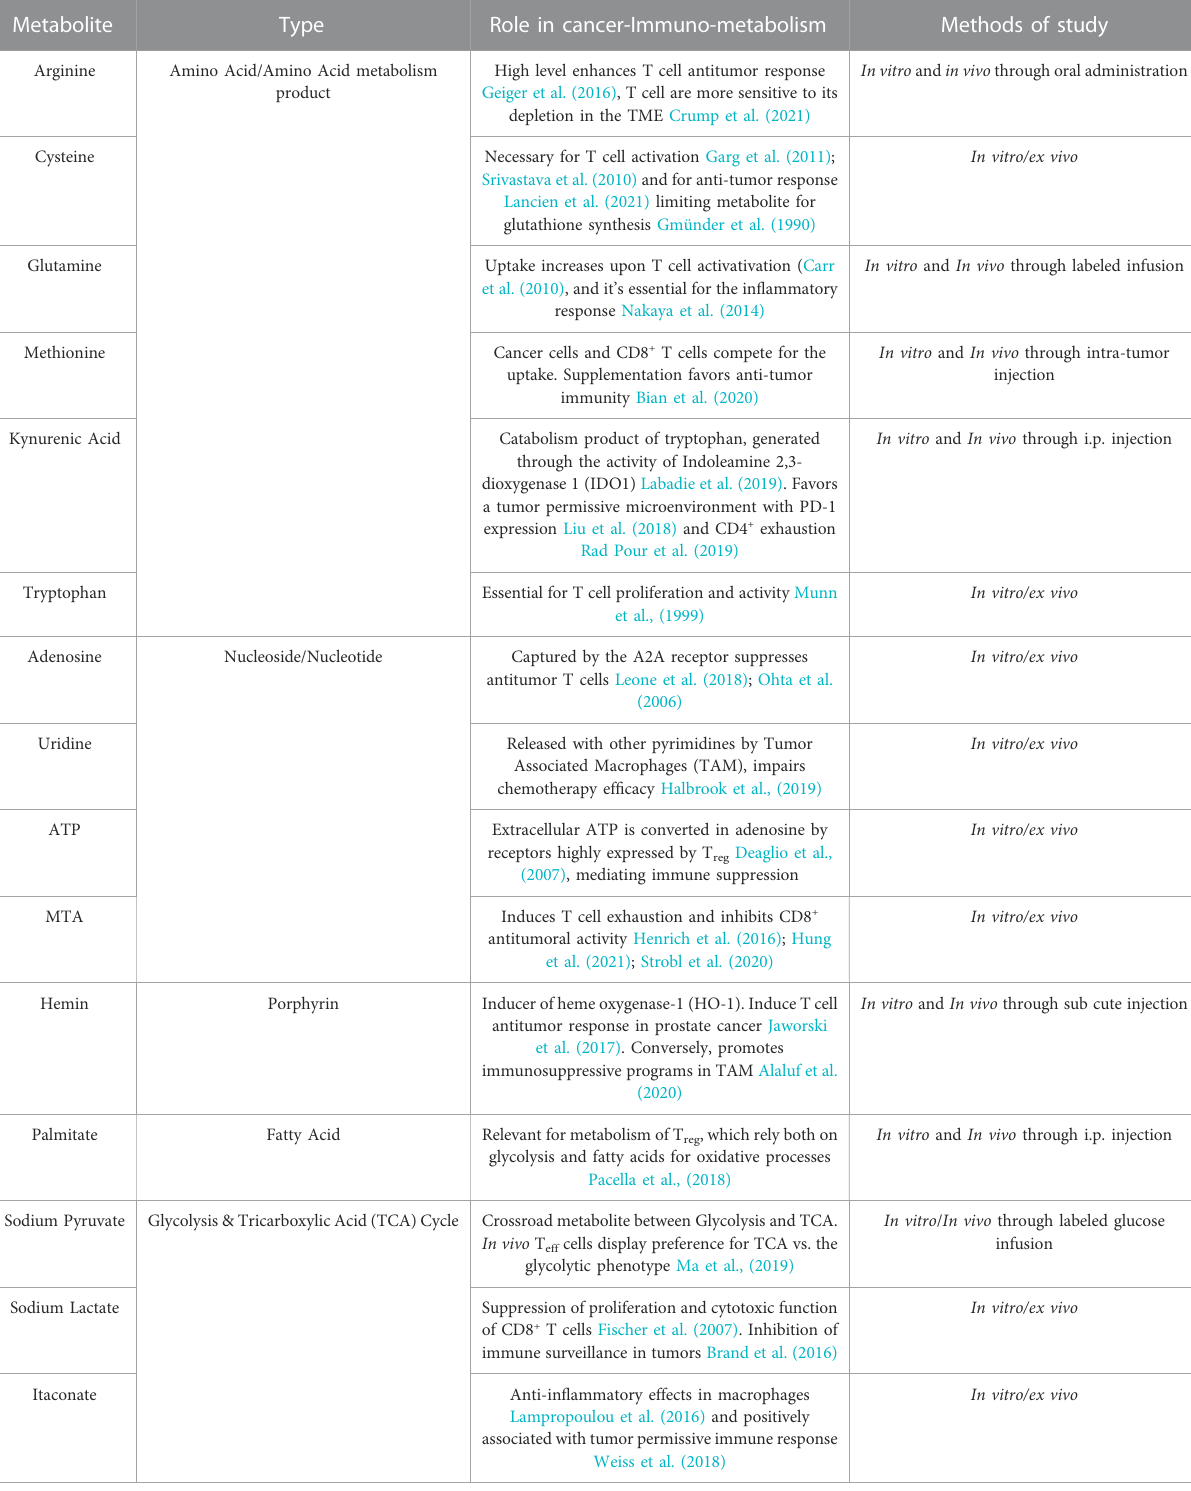
TABLE 1 Metabolites delivered with the bio microdevice in the MMTV-PyMT mice